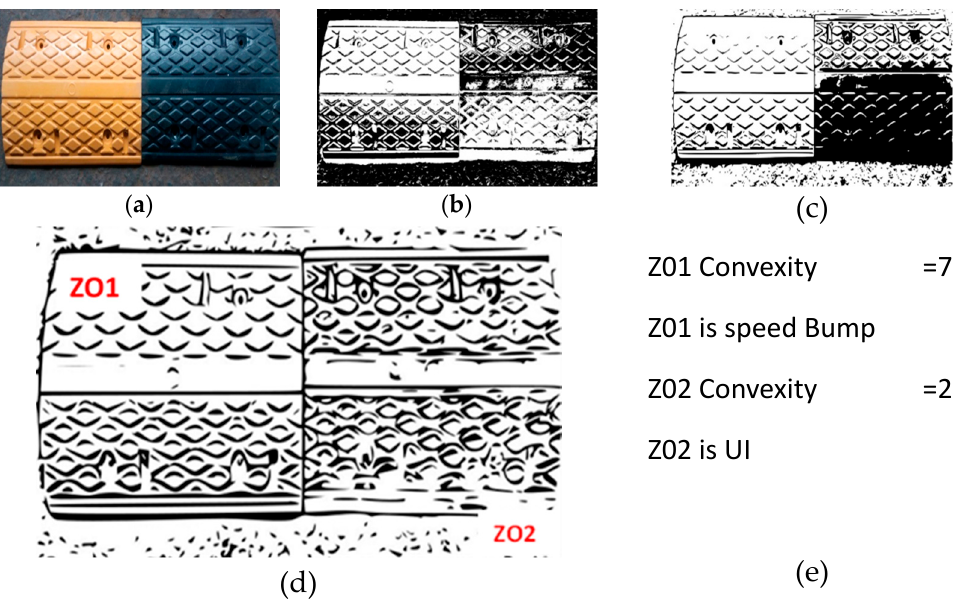
Figure 6. Procedure to categorize the image using the proposed method: ( a ) original image; ( b ) processed image; ( c ) further processed image; ( d ) image after Hanuman algorithm; ( e ) report of Hanuman algorithm.